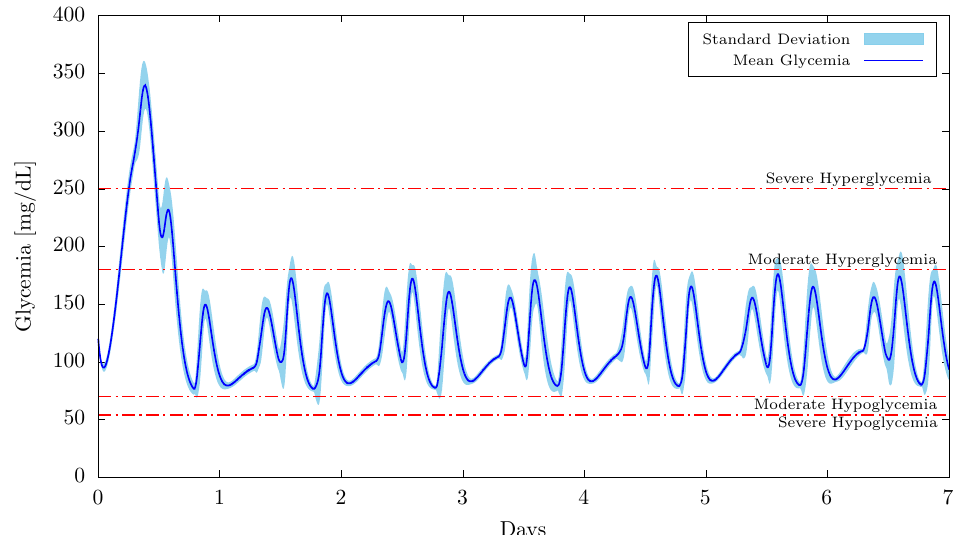
Figure 3. Mean glycemia and standard deviation for 20 patients and considering w 0 = 0 .